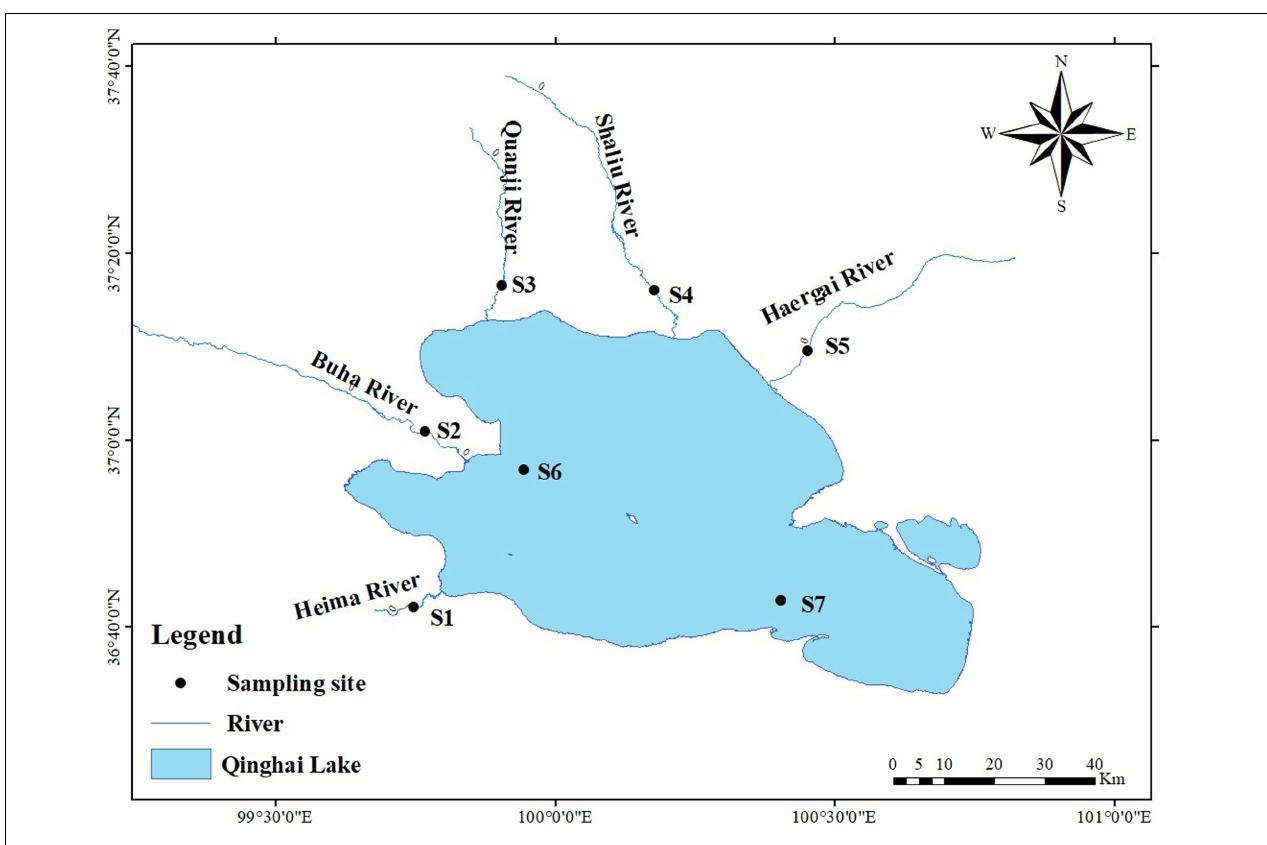
FIGURE 1 | Sampling sites of Gymnocypris przewalskii .